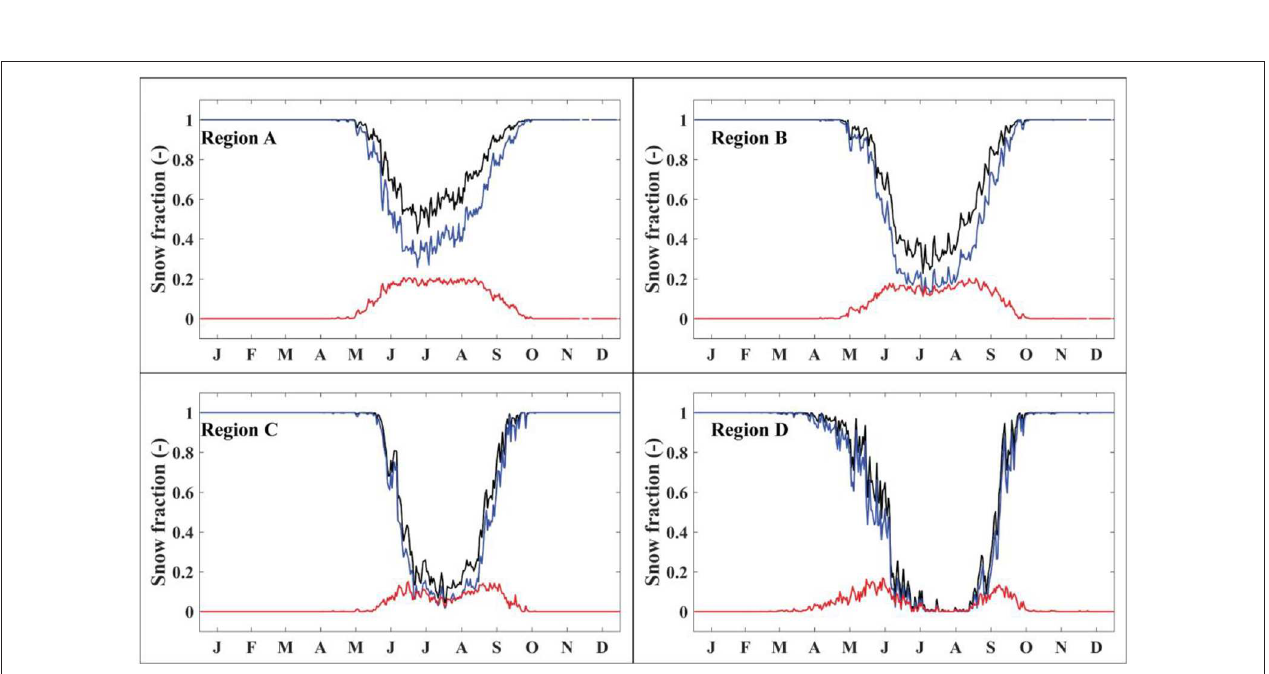
FIGURE 9 | Fraction of snow precipitation to total precipitation averaged for each day (for all 13 years of the model runs) over the entire glacier surface for the control run (black lines) and for + 1 ◦ C temperature change (blue lines). Discontinuities in some lines indicate days in which no precipitation occurred on that day for all 13 years. The red lines show the difference in fraction of precipitation that falls as snow between the control runs ( 1 T = 0 ◦ C) and runs with a temperature change ( 1 T = + 1 ◦ C).